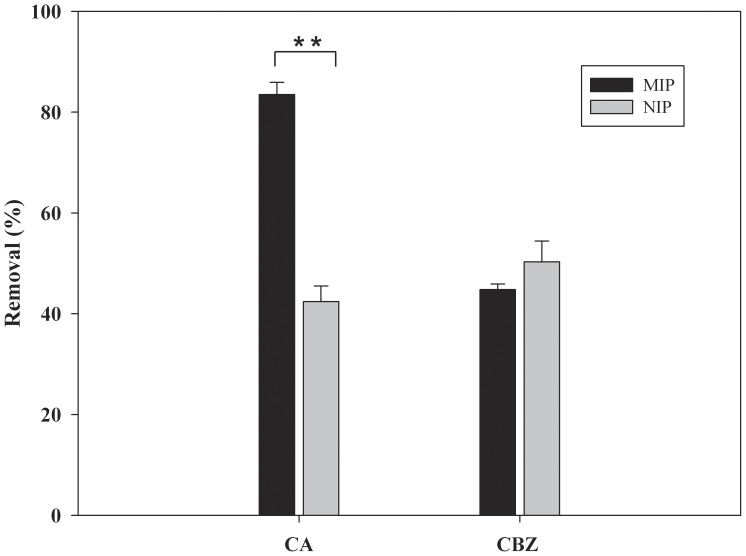
Adsorption selectivity of MIP (mean ±SD, n = 3; *p<0.05).